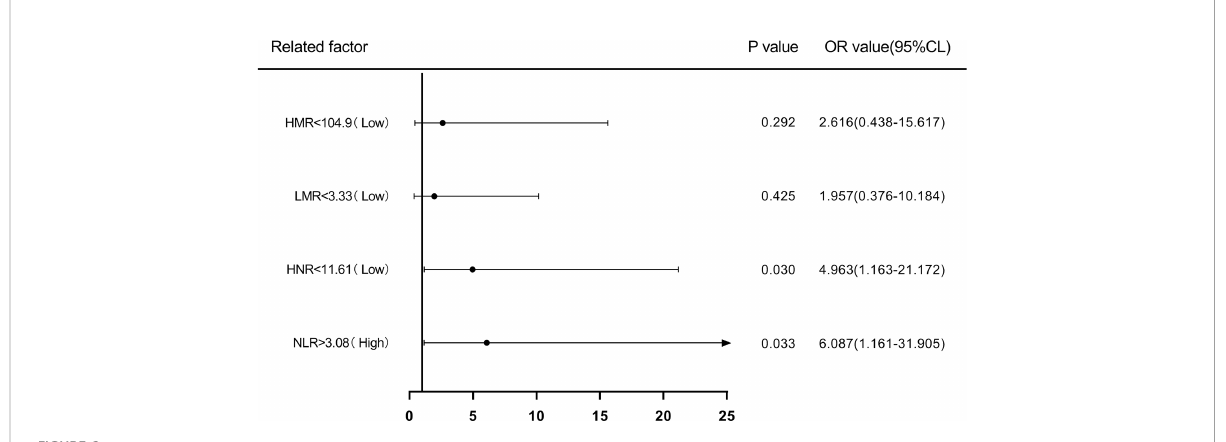
FIGURE 6 Forest plot of multifactorial logistic regression analysis of NLR, LMR, HNR, and HMR (two groups of classi fi cation) in predicting NSCLC metastasis. (Note: multifactor correction included variables ANC, ALC, AMC, HDL).